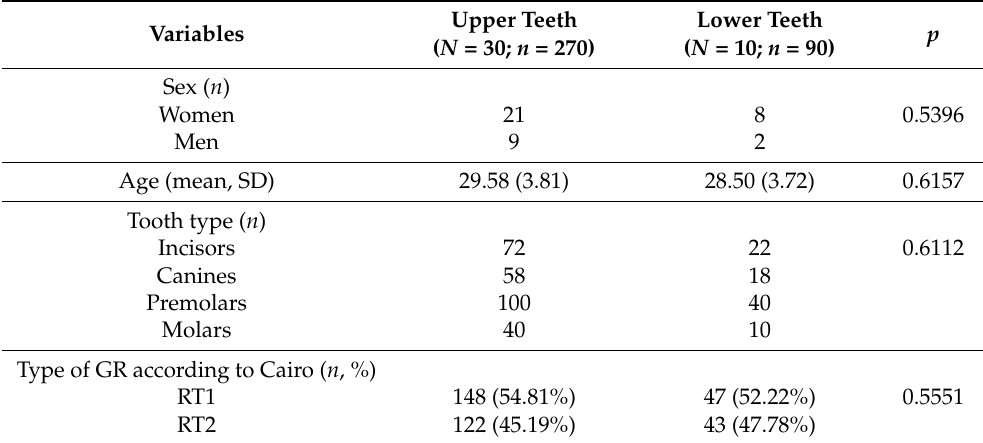
Table 1. Characteristics for the study groups.